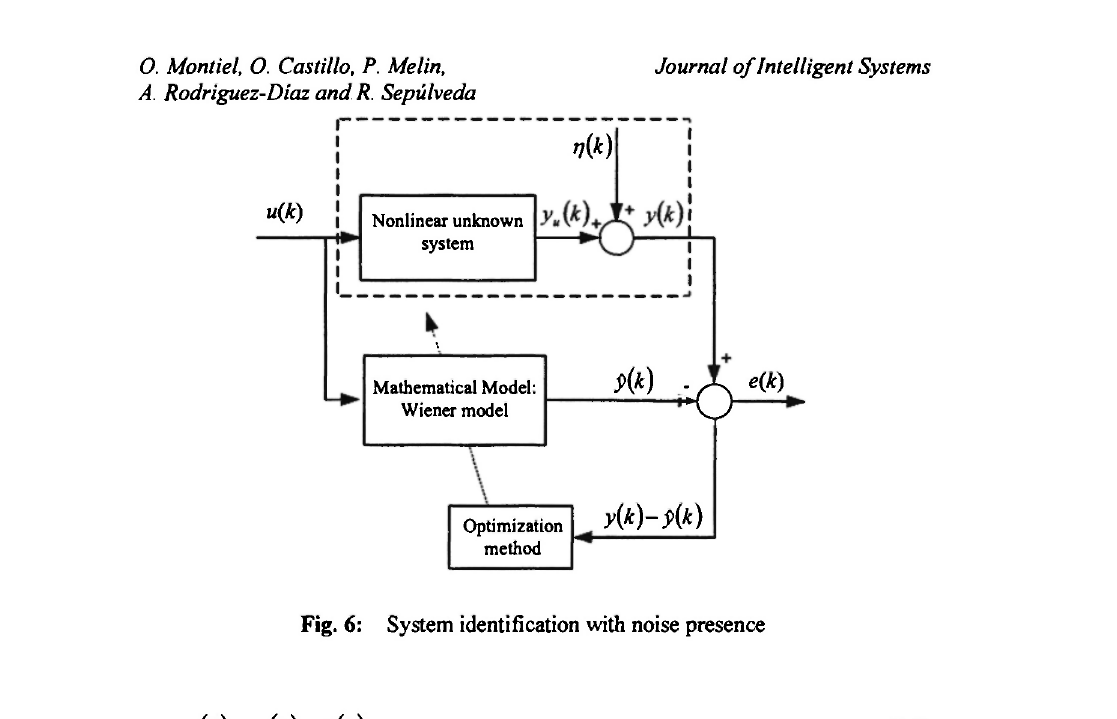
Fig. 6: System identification with noise